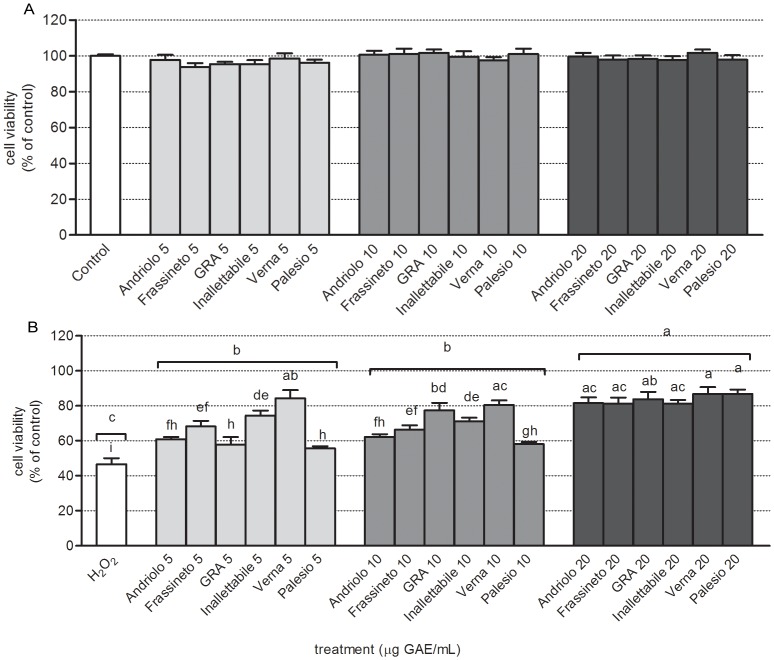
Evaluation of cell viability in primary cultures of neonatal rat cardiomyocytes.Cells were pre-treated with different concentrations (5, 10, 20 µg GAE/mL) of phenolic extracts of wheat varieties for 24 h after which oxidative damage was induced by treating cells with 100 µM H2O2 for 30 min. Cells were allowed to recover in fresh medium for additional 24 h after the stress and cell viability in the absence/presence of 100 µM H2O2 was assayed by MTT test as reported in Materials and Methods. Panel A represents cell viability levels in cells pre-treated with different phenolic extracts for 24 h, while panel B reports cell viability levels measured in cells pre-treated with different concentrations of phenolic exctracts for 24 h and stressed by H2O2 treatment. Data are reported as percent of control untreated cells and represent mean +/− SEM of 4 independent experiments, each in triplicate. Statistical analysis of differences was carried out by two way ANOVA followed by Fisher's LSD as post test. Different letters represent statistically significant differences (p<0.05) among wheat varieties at the same concentration (lower letters) and among different concentrations (upper letters).